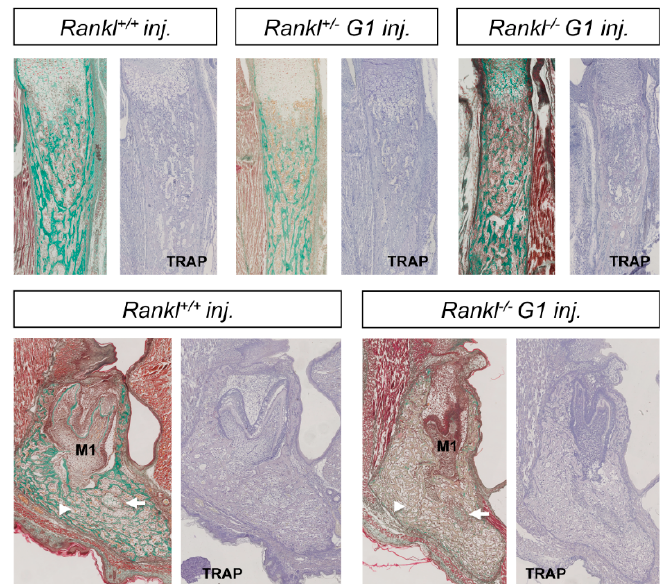
Figure 7. Histological comparative analysis of the skeletons of wild type, heterozygous, and first-generation Rankl null mutant pups born to females treated with IK22-5 during the second half of pregnancy. Masson trichrome staining of longitudinal sections of tibias made it possible to observe an osteopetrotic phenotype in all genotypes with, however, graduated severity from wild type to null mutant. TRAP staining was negative in all sections, signaling the absence of osteoclasts, induced by the IK22-5 injections. Masson trichrome staining of mandible frontal sections in the plane of the first molar (M1) revealed the induction of an osteopetrotic phenotype in the wild type pup with significant mandibular bone density (arrowhead), an absence of incisor in this section plane, remnant Meckel cartilage (arrow), and abnormal tooth morphology. TRAP staining of adjacent sections revealed a total absence of osteoclasts. Concerning the null mutant pups, a phenotype similar to the second-generation mutant pup was observed, with significant mandibular bone density (arrowhead), remnant Meckel cartilage (arrow), and abnormal tooth morphology. Magnification 40 × . Numbers of pups: 3 +/+, 6 +/ − , and 2 − / −